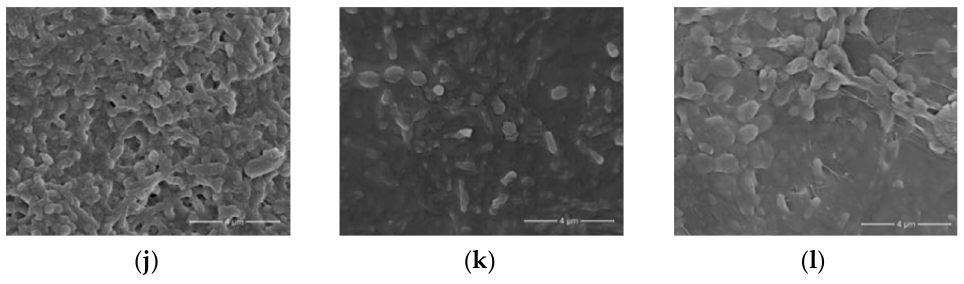
Figure 6. Micrographs of bacterial cells immobilized in various sol-gel matrices. ( a ) Transmission electron microscopy (TEM) image of E. coli bacteria entrapped in a ferrihydrite gel [30]; ( b ) trans- mission electron microscopy. Thin-cross-section TEM images of E. coli cells entrapped within an SS matrix after 24 h [32]; ( c ) field emission scanning electron microscopy images of bacteria/TiO 2 gel hybrid spheres using Str. Theromophilus as templates, with the inset of a magnified image. The surface sol-gel deposition was repeated five times [54]; ( d ) different types of biocer-microstructure (scanning electron micrographs) carbon felt coated with a silica– B. sphaericus layer [55]; ( e ) transmission electron microscopy of the E. coli B 54,125 cell within an aqueous silica gel, SiO 2 –glycerol 10%, aged for one day [27]; ( f ) scanning electron microscopy (SEM) photos of mold silica gel-entrapped P. aeruginosa MR01 immediately after gel immobilization [43]; ( g ) SEM image of silica matrices with immobilized bacteria [44]; ( h ) SEM micrographs of Sphingomonas sp. cells [56]; ( i ) biohybrid of Sphingomonas sp.- ( f ) Si NP immobilized on microplate [56]; ( j ) SEM images of biofilm surface. Silica layer present after encapsulation. Representative electron microscopy images of N. europaea biofilm 30 min after encapsulation [57]; ( k ) 30 days after encapsulation [57]; ( l ) 90 days after encapsulation. Scale bars represent 4 mm [57]. Micrographs reprinted with permissions from the given references.